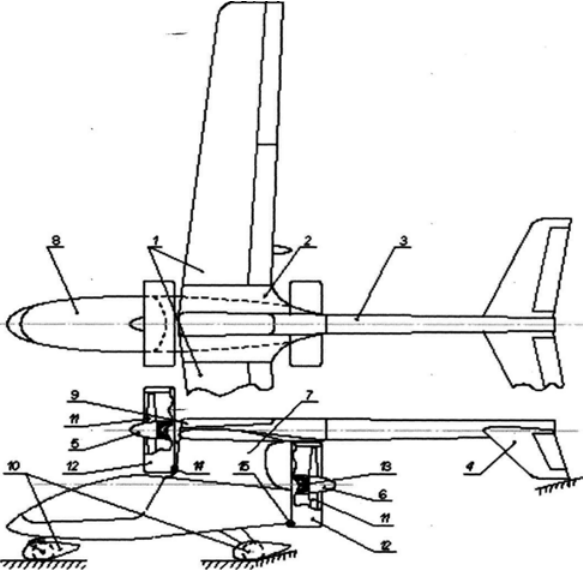
Fig. 5. Top and side view of the twin-engine UAV equipped with the variable thrust vector PP PP can turn on the vertical plane on angle φ in rela- tion to hinges 14 and 15.